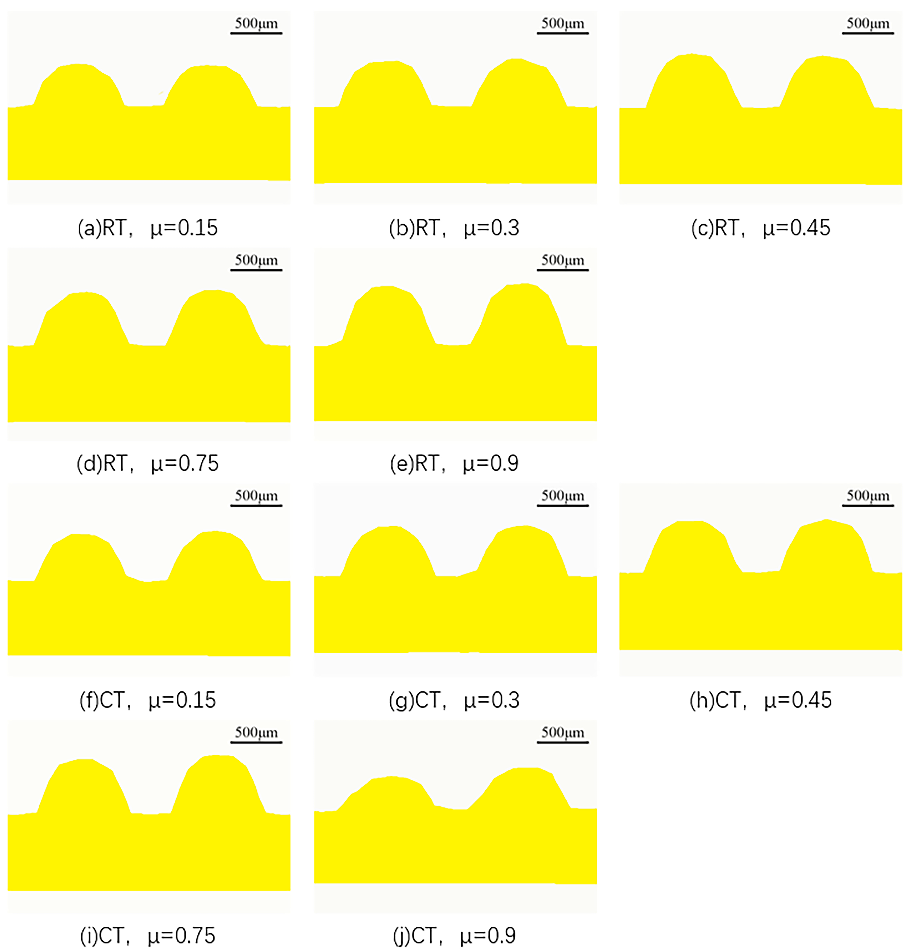
Figure 20. Cross-sectional area of three-dimensional morphology of micro-groove fins produced by extrusion machining under different conditions.